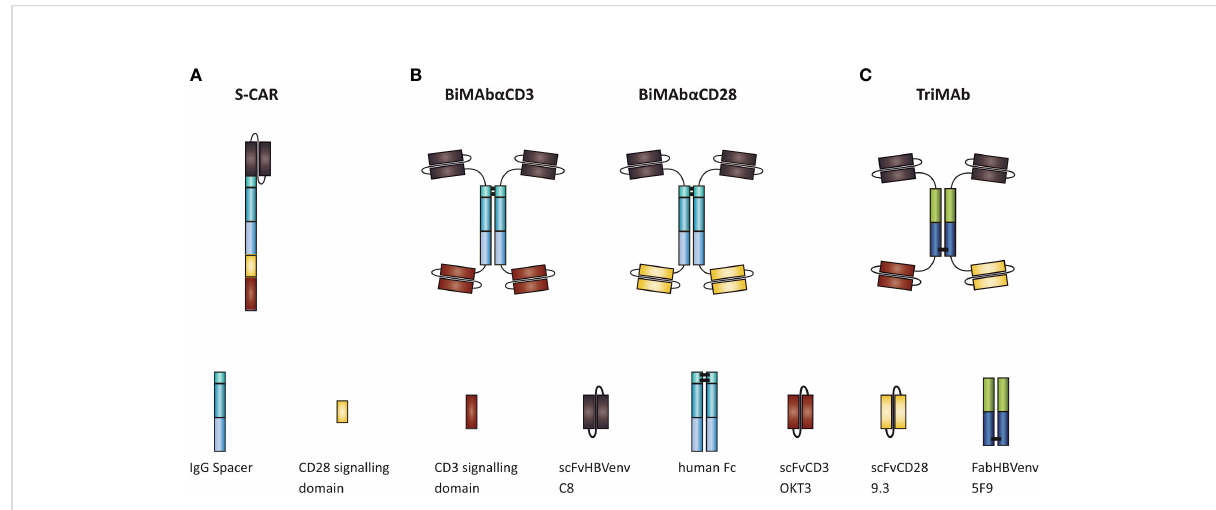
FIGURE 1 Schematic representation of (A) S-CAR, (B) BiMAb, and (C) TriMAb. All constructs contain the single chain fragment variable C8 for speci fi c targeting of HBV-infected